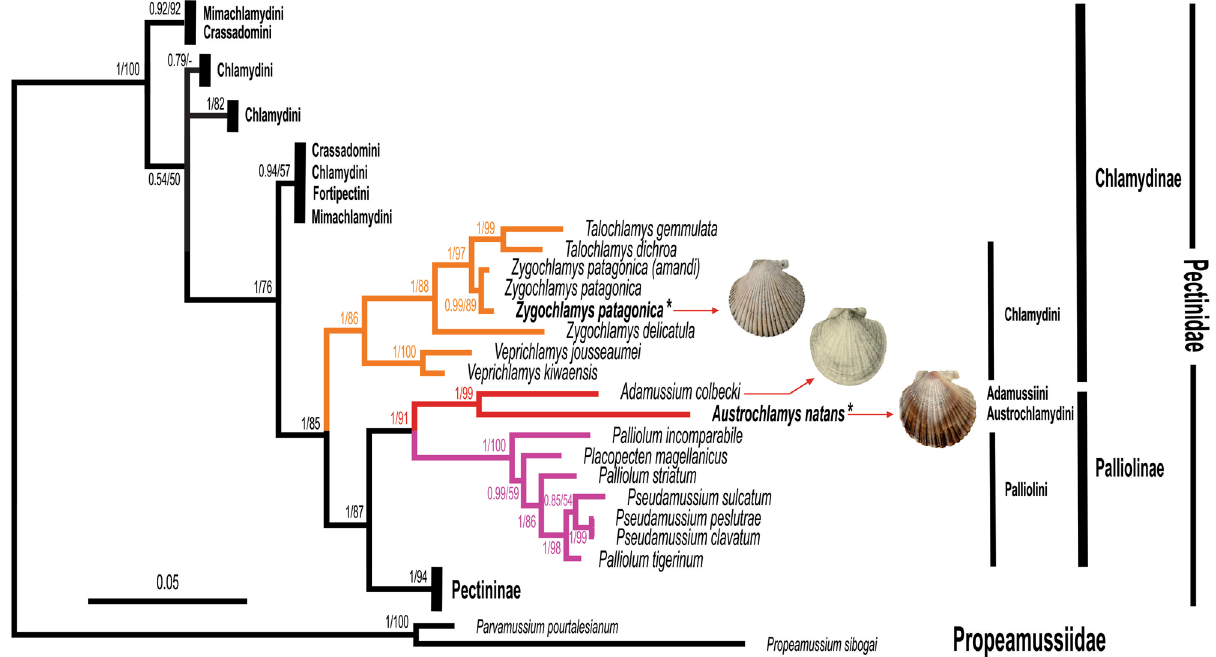
Figure 5. Phylogenetic relationships among 92 pectinid species based upon the combined dataset (12S-16S- 28S) using Bayesian inference (BI) and maximum likelihood (ML, not shown) probabilistic methods. Branch support values are indicated near each node: The first number represents the portion of sampled trees in which the node was found (posterior probability, pp); the second number is the bootstrap support (bs) value > 50; (−) indicates values < 50. The illustration of Ad. colbecki was modified from Smith 24